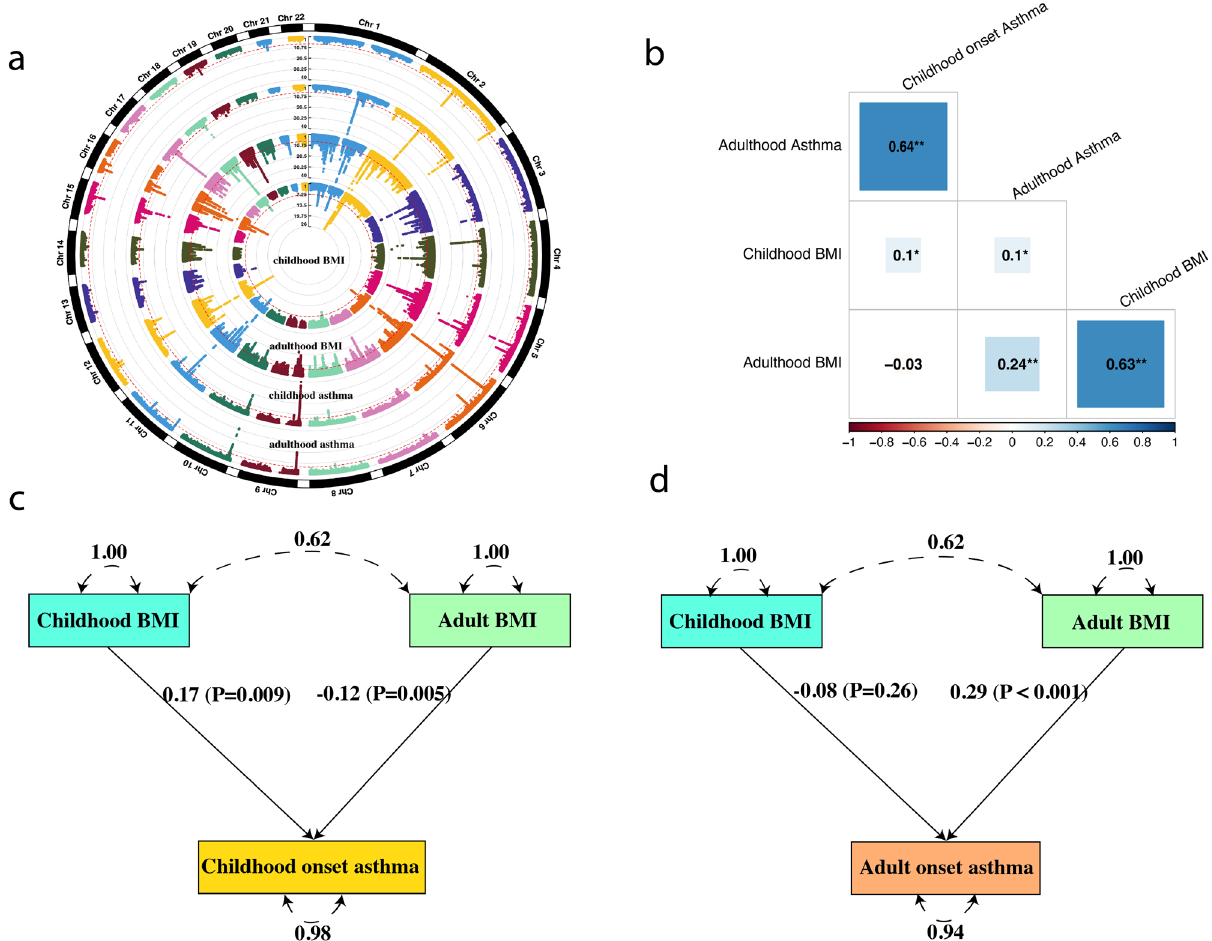
Fig. 2 Genetic association between body mass index and childhood- and adult-onset asthma. a The circle Manhattan plot shows P -values of genome- wide association studies (GWAS) for body mass index (BMI) and childhood- and adult-onset asthma. From inner to outer circle: childhood BMI, adult BMI, childhood-onset asthma, and adult onset asthma. The circle Manhattan plot is customized to truncate the P -values at 1 × 10 − 40 . b The genetic correlation coef fi cients for each pair of traits. The nominal signi fi cance level of genetic correlation ( P < 0.05) is marked by one asterisk, and P < 0.01 is marked by two asterisks. c , d Genetic multivariable regression in genomic structural equation modeling evaluates the association between BMI and childhood- and adult- onset asthma. c The association between childhood BMI and childhood-onset asthma adjusting for the genetic effects of adult BMI. d The association between childhood BMI and adult onset asthma adjusting for the genetic effects of adult